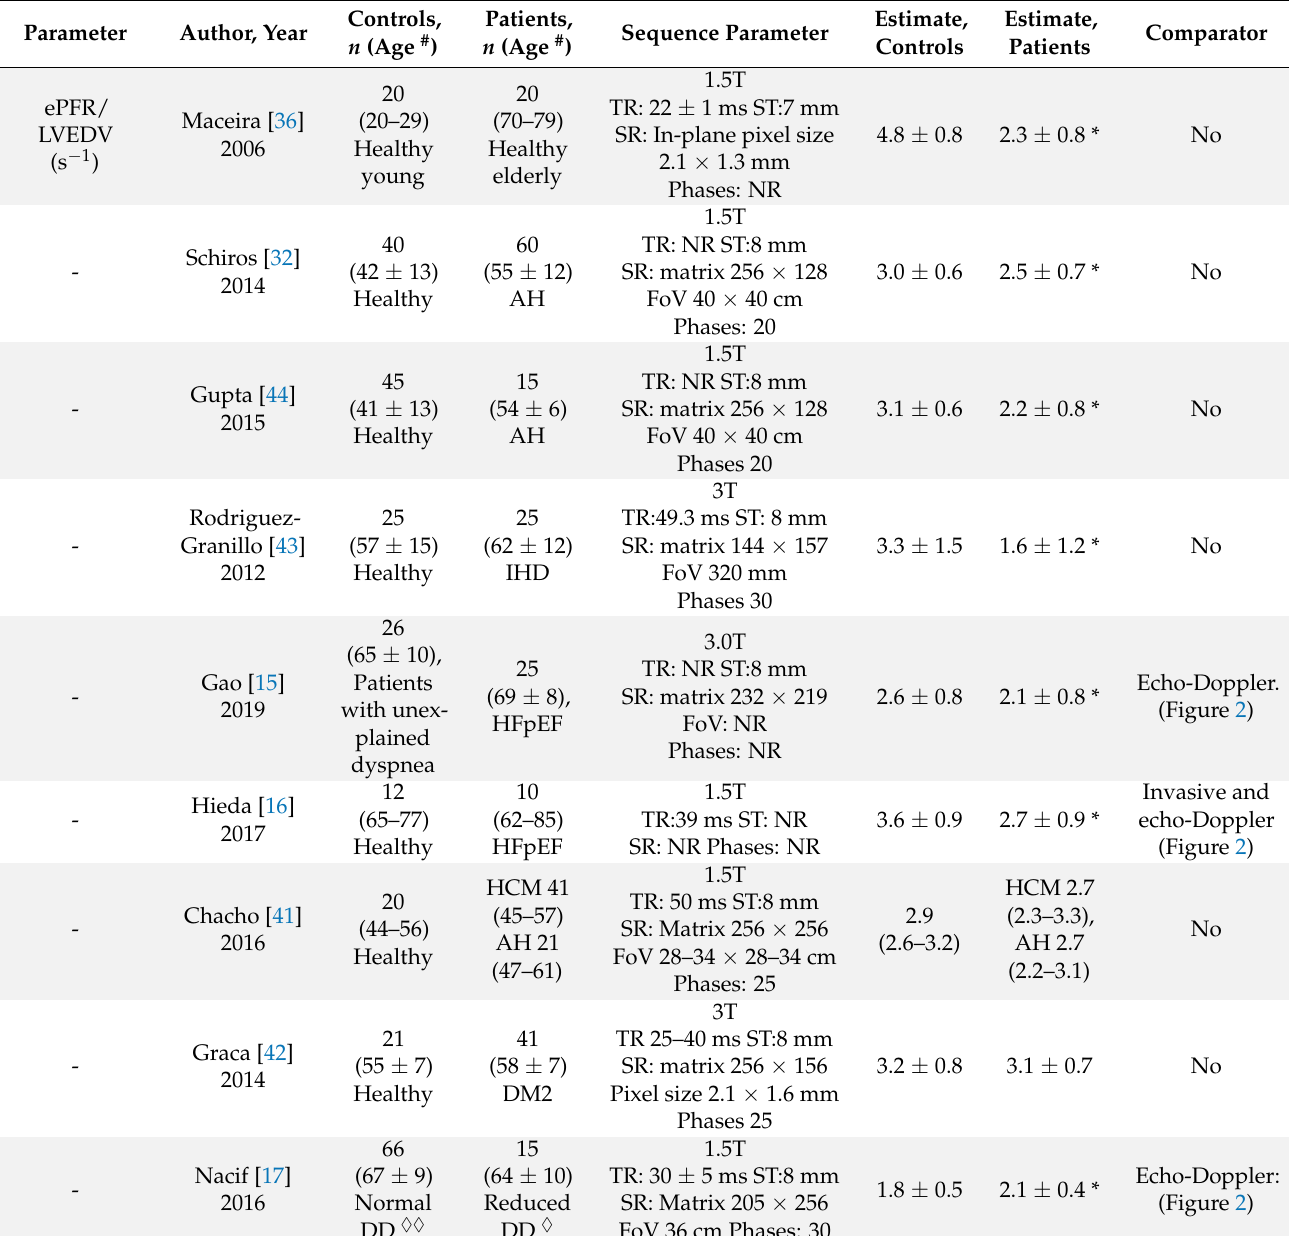
Table 6. LV time/volume curves—early peak filling rate indexed to LV end-diastolic volume.